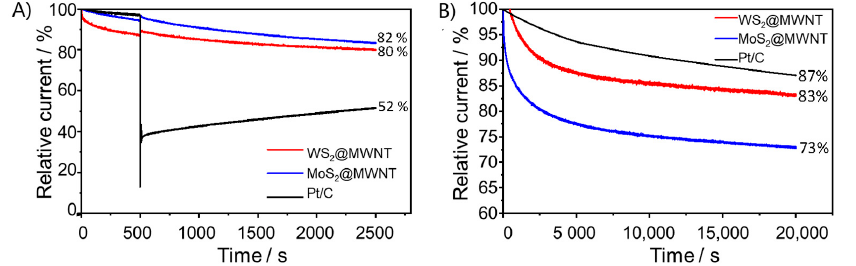
Figure 4. Methanol resistance and stability studies of the WS 2 @MWNT, MoS 2 @MWNT and Pt/C: ( A ) chronoamperometric responses with the addition of 0.5 mol · dm − 3 methanol (at 500 s) and ( B ) chronoamperometric response at E = 0.41 V vs. RHE (O 2 -saturated 0.1 mol · dm − 3 KOH, and at 1600 rpm) for 20,000 s.